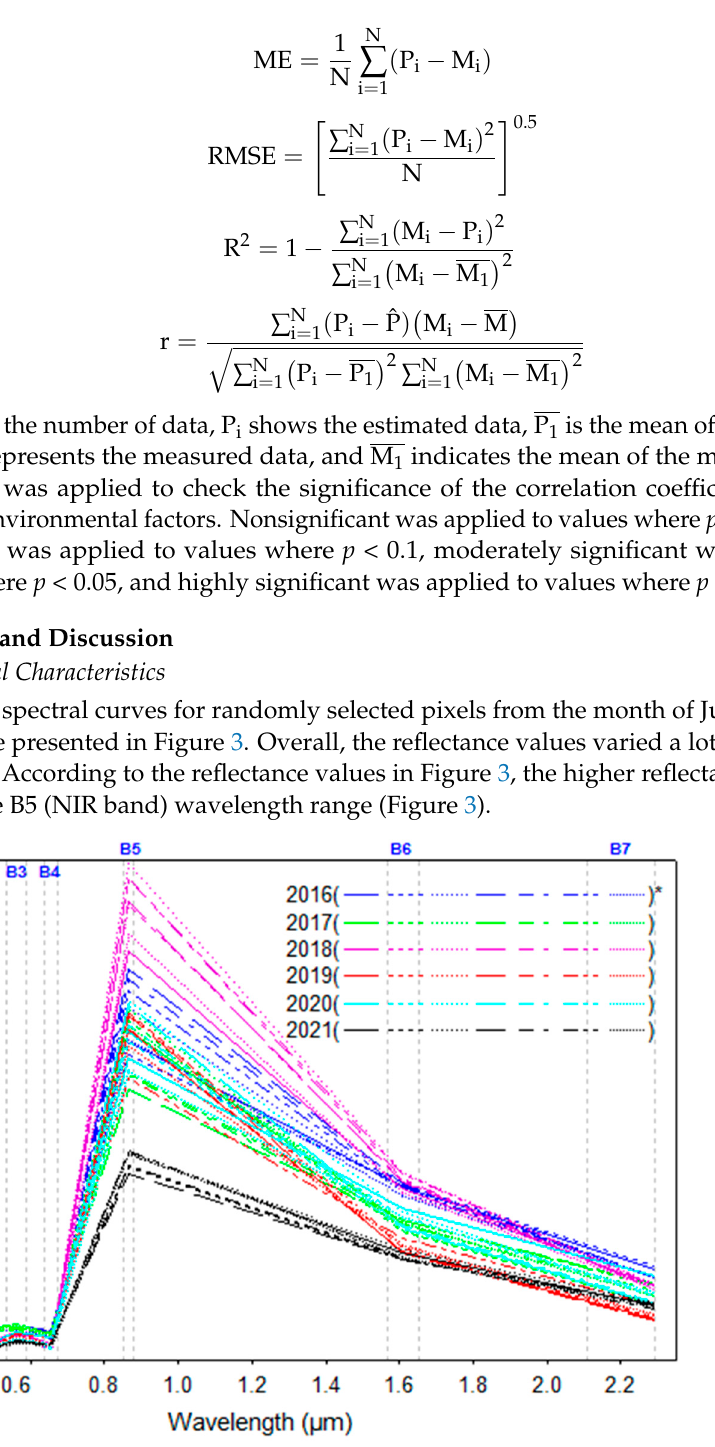
Figure 3. The spectral reflectance from some randomly selected pixels from the month of July in different years (* the selected pixels).